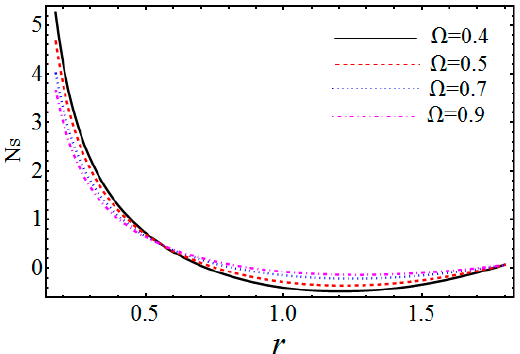
Figure 16. Curves of Ns with fixed Ω where θ = 0.1, ϕ = 0.8, δ = 0.01, ε = 0.01, V = 0.3, λ 1 = Figure 16. Curves of 𝑁𝑠 with fixed Ω where 𝜃 = 0.1, 𝜑 = 0.8,𝛿 = 0.01, 𝜀 = 0.01,𝑉 = 0.3, 𝜆 (cid:2869) = 1, 𝑧 = 1, z = 0, t = 0.1, Γ = 0.4, Gc = 0.01, Nt = 0.5, Br = 1, Gr = 5, Λ = 1, Nb = 0.9, Q = 1. 0, 𝑡 = 0.1, Γ = 0.4,𝐺𝑐 = 0.01, 𝑁𝑡 = 0.5,𝐵𝑟 = 1, 𝐺𝑟 = 5, Λ = 1, 𝑁𝑏 = 0.9, 𝑄 = 1.